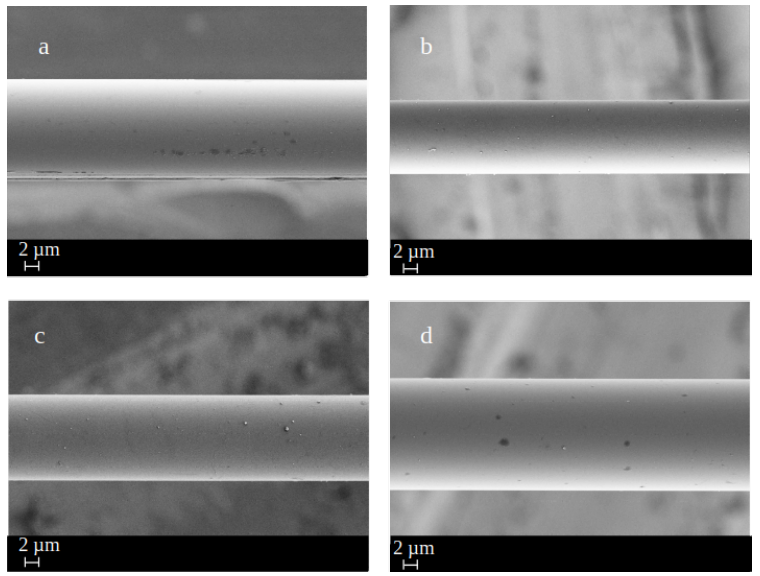
Figure 7. IPF fibers sized with AMEO ( a ) and coated with: SB ( b ), SB-MMT ( c ), and CSB ( d ). Magification 2.00 K ×